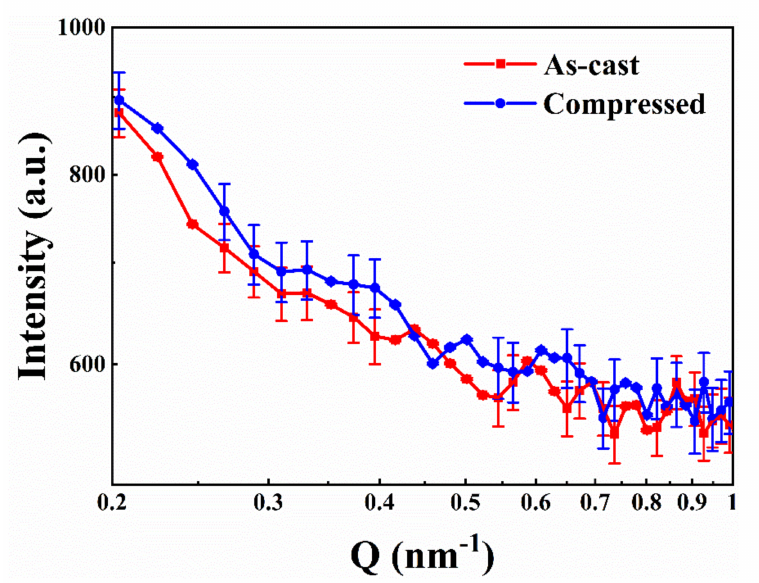
Figure 4. SAXS intensity of the as cast and compressed